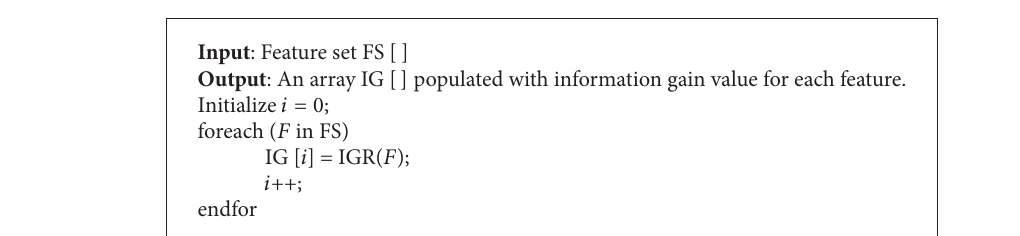
Figure 1: The proposed system architecture.